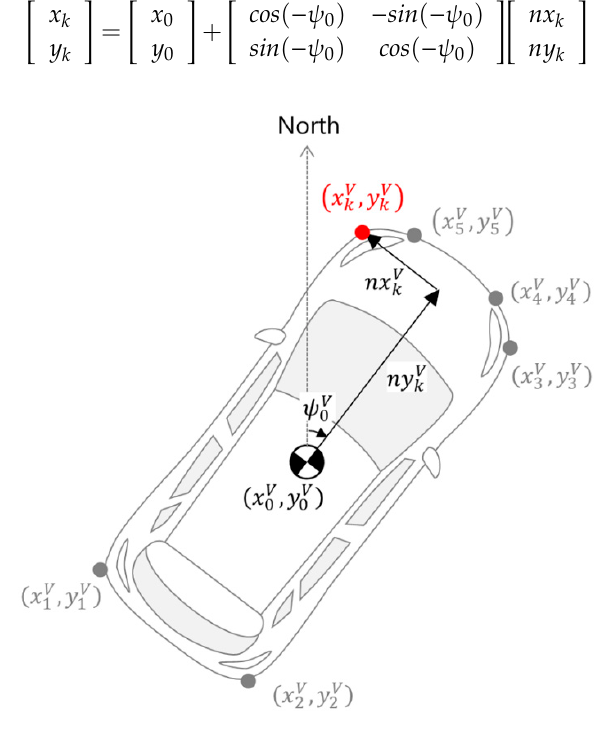
Figure 3. Node Figure 3. Node coordinates.